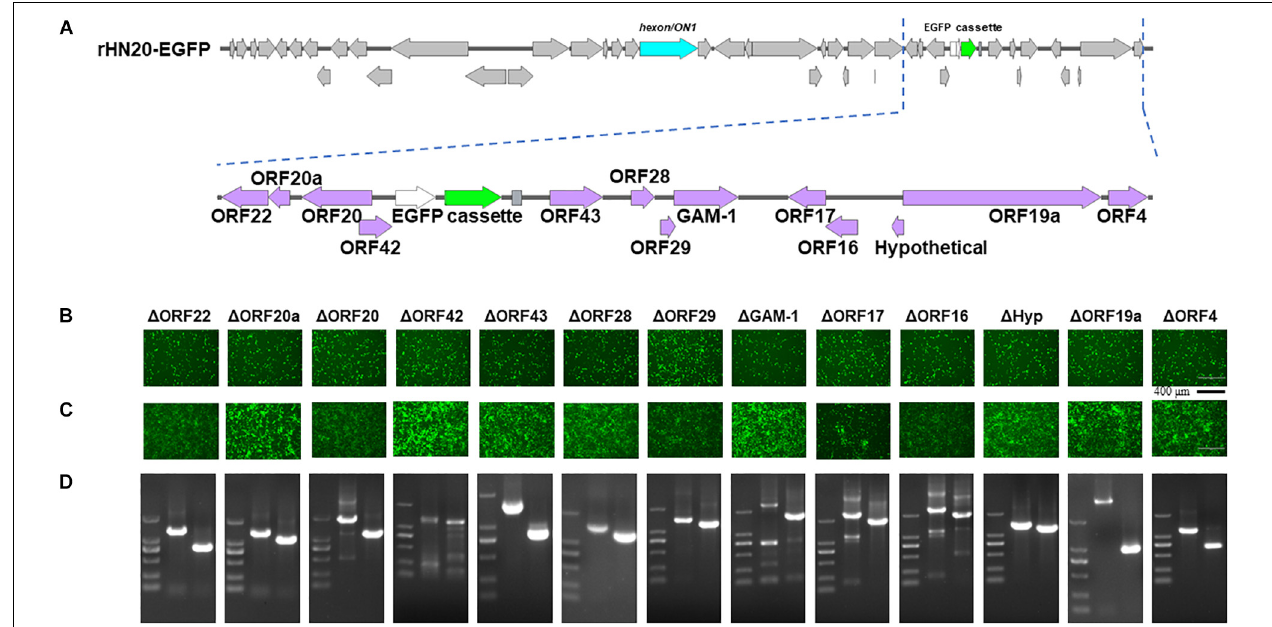
FIGURE 3 | Identification of non-essential open reading frames (ORFs) in the right of the FAdV-4 genome. (A) Diagram of the genomic structure of rHN20-EGFP. Focal amplifications in purple represent ORFs unique to fowl adenoviruses on the right. (B) Green fluorescence in LMH cells transfected with linearized ORF knockout recombinant fosmids at 48 h post-transfection. Scale bar, 200 µ m. (C) Green fluorescence in LMH cells infected with ORF knockout recombinant viruses at 72 h post-infection. Scale bar, 200 µ m. (D) PCR identification of ORF knockout recombinant virus. A fragment of each recombinant virus containing the knockout ORF flanked was amplified, and rWT-EGFP was used as a